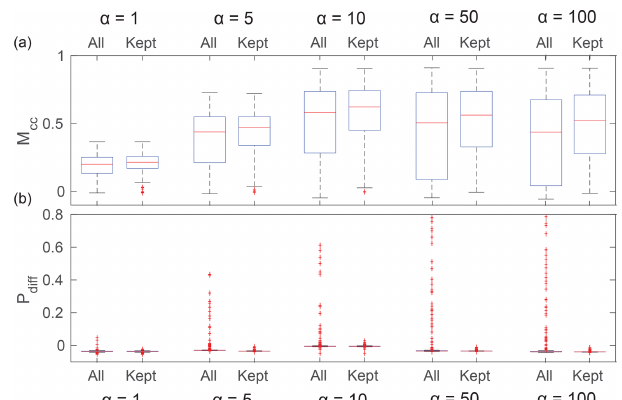
Figure 9. (a) Box plot of Matthews correlation coefficient, Mcc, when Mcc (cid:54)= 0 and Mcc (cid:54)= 1 and (b) positive difference percentage, P diff , when Mcc = 0 (no matched pixel) for all images and for the images kept given different values of the mask reconstruction pa- rameter α